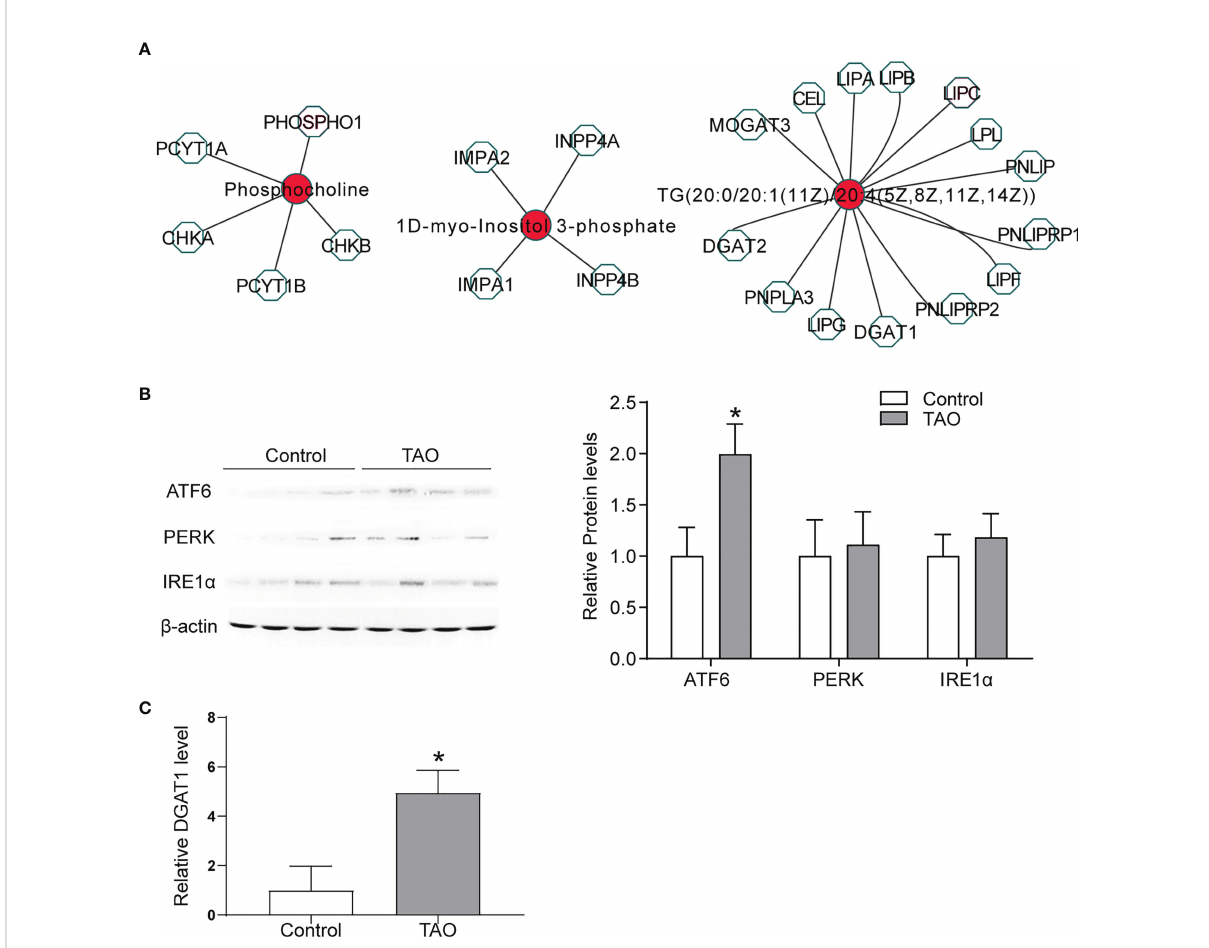
FIGURE 5 Biological signi fi cance of metabolites. (A) Networks of the metabolites and genes (fold change > 2) were visualized utilizing Metscape 3. (B) ATF6, PERK, and IRE1 a expressions were detected by western blot in orbital adipose/connective tissue from TAO patients (n = 4) and control donors (n = 4) (* P < 0.05). (C) DGAT1 expression was detected by qRT-PCR in orbital adipose/connective tissue from TAO patients (n = 3) and control donors (n = 3) (* P <